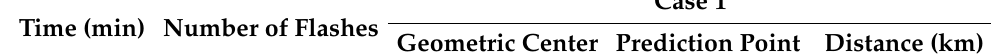
Table 4. Real lightning events and the predicted results given by the system per minute in Case 1 (to facilitate the display, the latitude and longitude data in the table are kept to two decimal places, and the original data to six decimal places were used to calculate “Distance” and draw Figure 21. (The “-” mark in the table represents missing data, and the same applies to the following